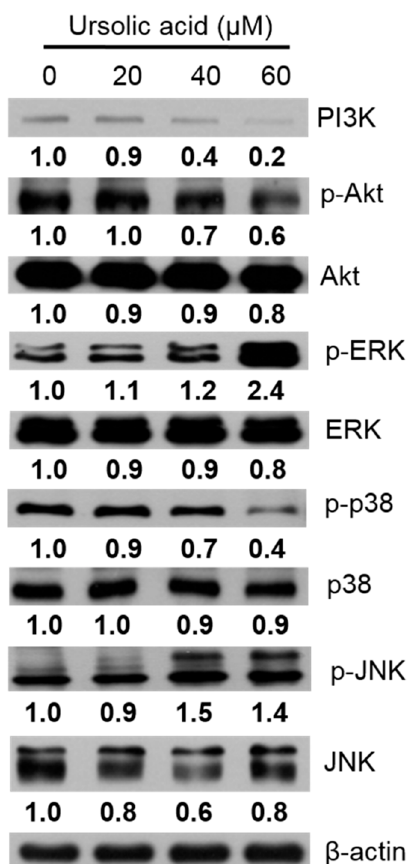
Figure 9. Effects of various doses of UA on the PI3K/Akt and MAPK signaling pathway in Huh-7 cells. The cells were treated with various doses of UA for 24 h. The levels of PI3K, p-Akt, Akt, p-ERK, ERK, p-p38, p38, p-JNK, and JNK were evaluated using western blotting, and β -Actin was used as a loading control.